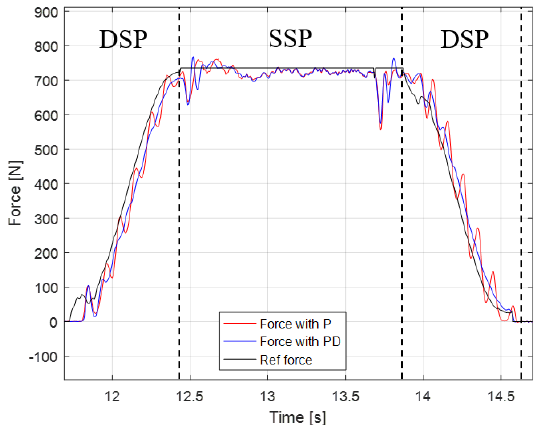
Figure 14. Leg length controller with proportional and proportional-derivative (PD) control.